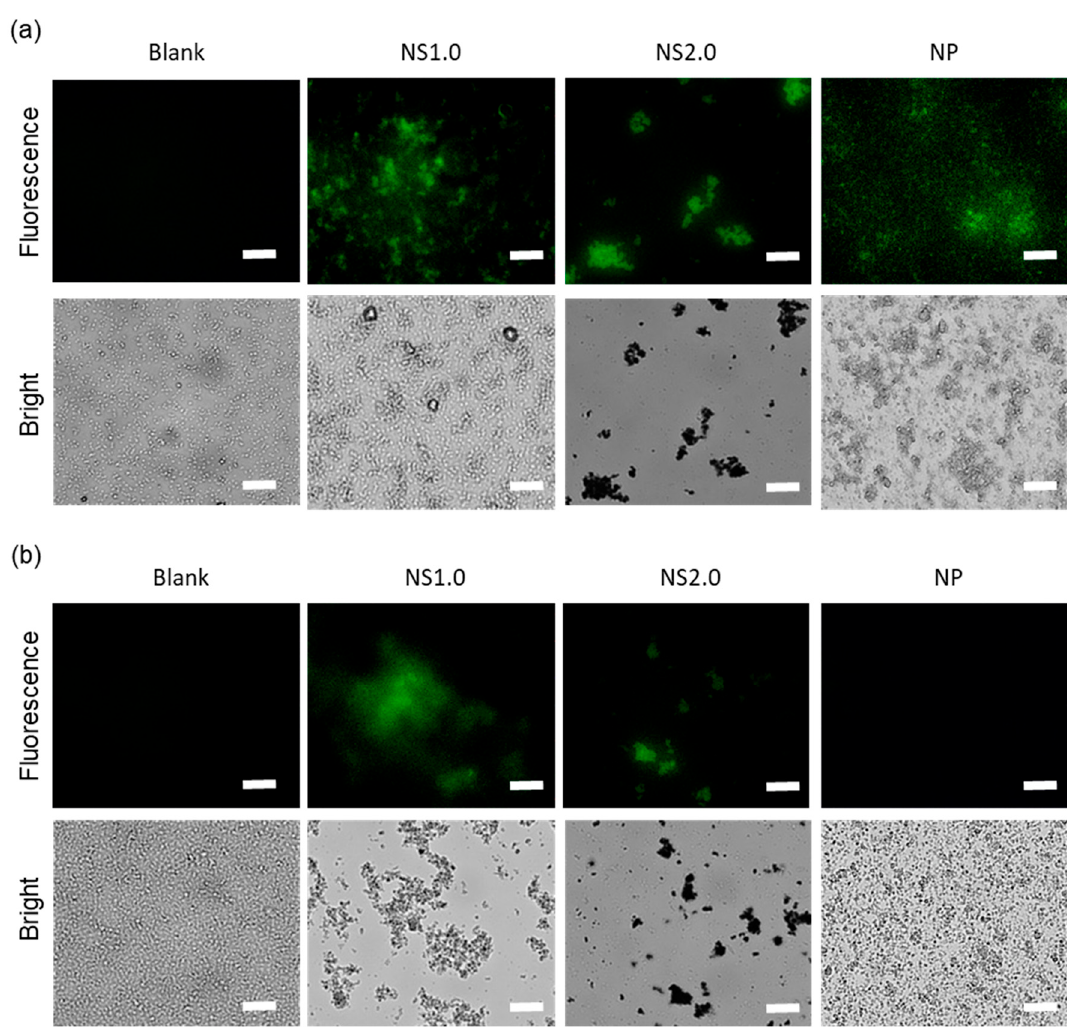
Figure 4. Intercellular ROS (reactive oxygen species) accumulation in S. mutans loaded with H2DCFDA (2 ′ ,7 ′ -dichlorodihydrofluorescein diacetate) in the presence ( a ) and absence ( b ) of UV irradiation conditions. Cells were observed under a fluorescence microscope (Upper panel) and a phase-contrast microscope (Lower panel). Scale bar: 250 μ m .